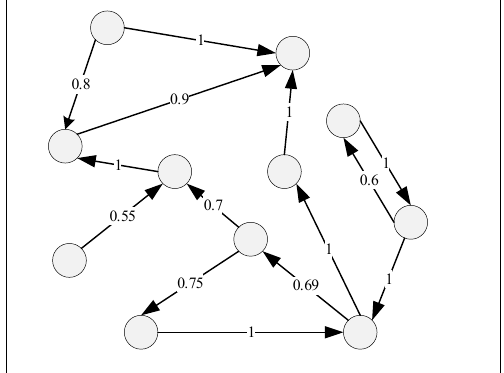
Fig. 1. The network model under